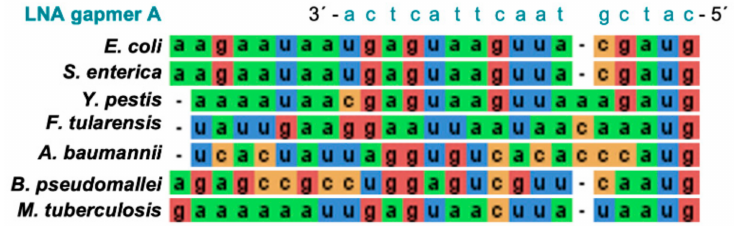
Figure 5. Sequence alignment of the − 21 to +3 translation initiation region of rne mRNA. A sequence alignment of the − 21 to +3 translation initiation region of the rne mRNA from Escherichia coli , Salmonella enterica, Yersinia pestis, Francisella tularensis, Acinetobacter baumannii, Burkolderia pseudomallei and Mycobacterium tuberculosis . Sequences were aligned using MAFFT [35] and coloured by nucleotide in JalView [36]. The complementary LNA gapmer A sequence is shown above the alignment to indicate the LNA gapmer A 1 /A 2 binding